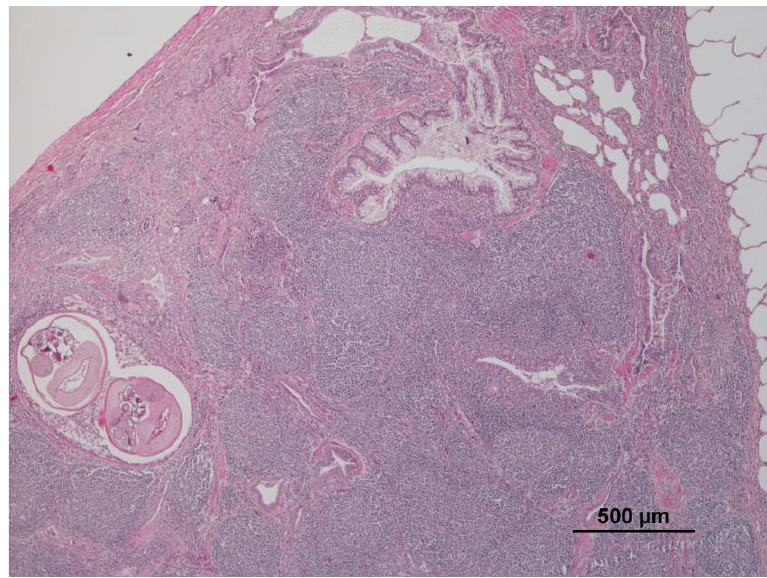
Figure 1. Severe lymphoid hyperplasia and verminous bronchitis (10×, 4×). Hemorrhage, with no associated organic response, was detected in 34.7% of the cases (25/72). Other lung lesions such as emphysema, alveolar proteinosis, and the presence of silicates and hemosiderin were also observed, although in lower proportion than others.